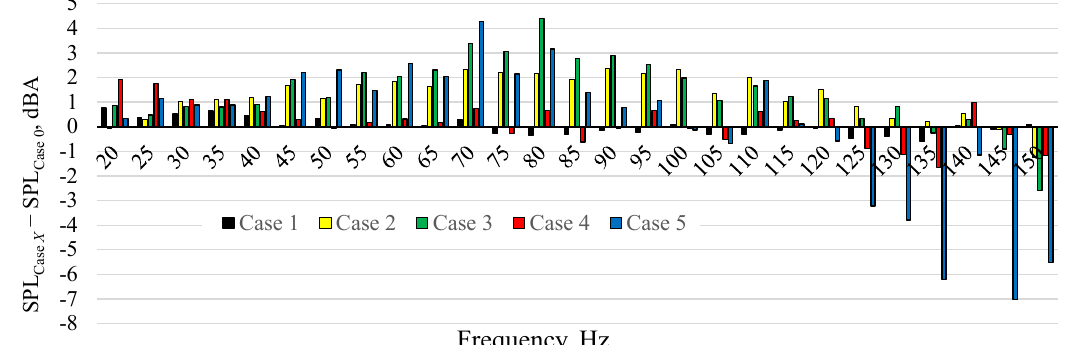
Figure 4. SPL differences between case 0 and other cases, where 𝑋 ϵ (cid:4668)1;2; 3;4; 5(cid:4669) .